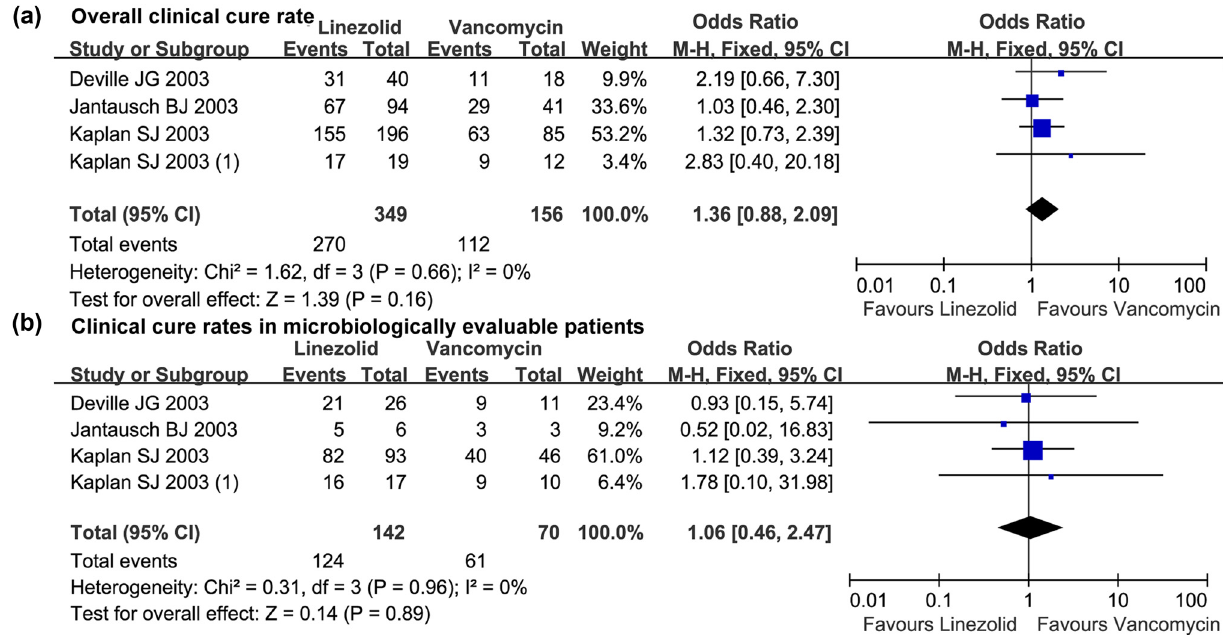
Figure 2: The forest plot of the clinical cure rate of linezolid vs vancomycin in children (< 12 years ) with resistant Gram - positive bacterial infections. ( a ) and ( b ) The comparative overall clinical cure rate and clinical cure rates in microbiologically evaluable patients treated with linezolid vs vancomycin in the treatment of resistant Gram - positive bacterial infections in children under 12 years. M - H, Mantel - Haenszel; CI, con fi dential